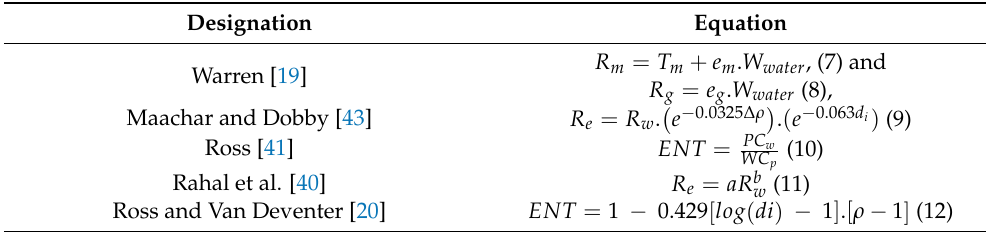
Table 2. Entrainment methods and models selected and tested in this